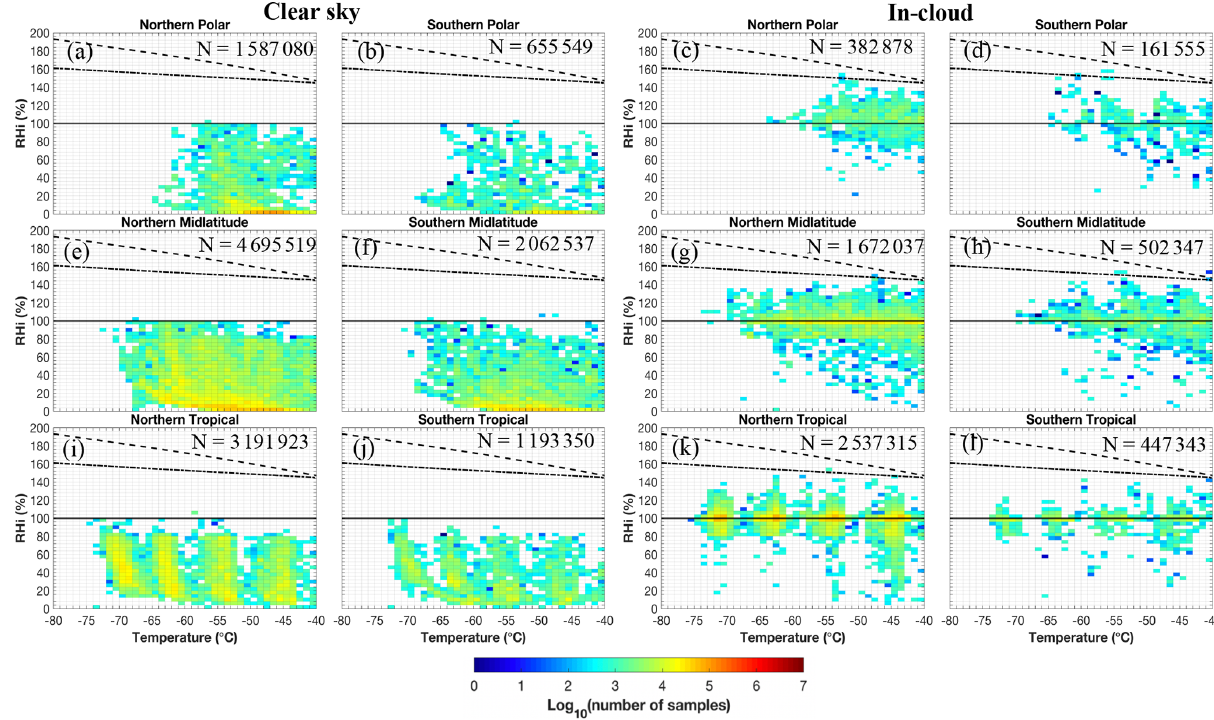
Figure 8. Similar to Fig. 6 but for CAM6-nudg data. RHi values for simulations are calculated using simulated specific humidity and temperature, based on the equation of saturation vapor pressure with respect to ice from Murphy and Koop (2005).